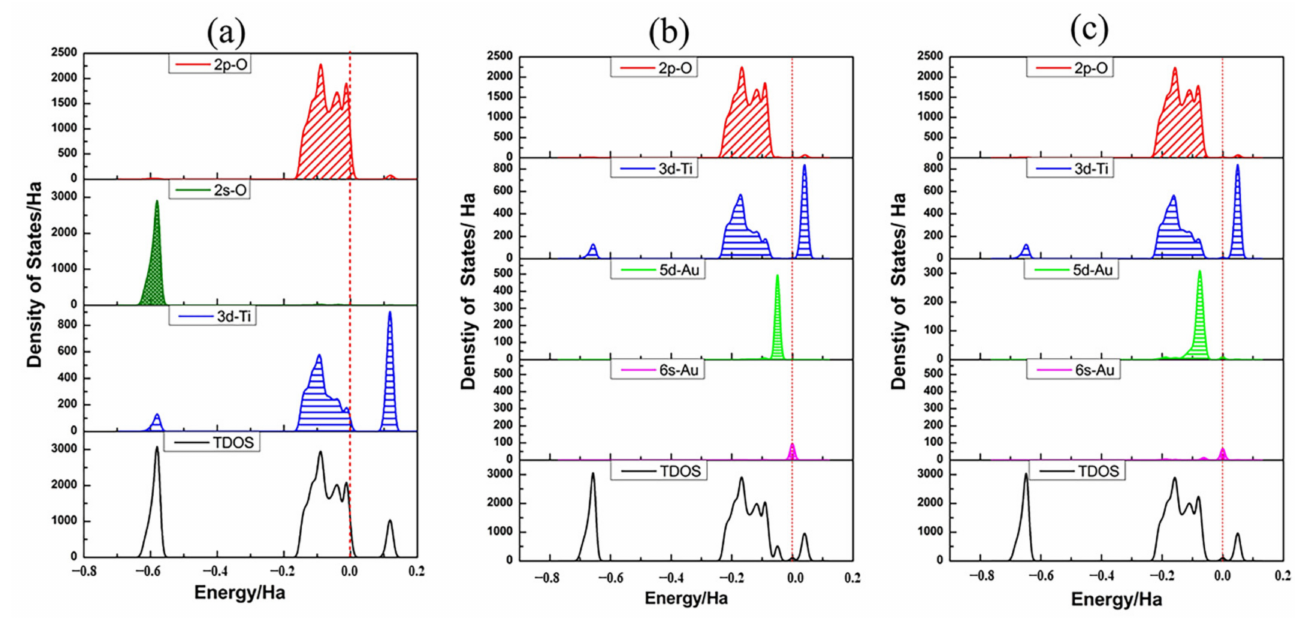
Figure 3. Density of state profiles and the partial density of states of TiO 2 NT (6,0) and Au and relevant nanotube surface atoms for a single Au adatom in two different adsorption states: ( a ) bare TiO 2 NT (6,0), ( b ) Au 1(O,O) , ( c ) Au 1(O,Ti) . The black curve is the sum of PDOS of O atoms, Ti atoms, and Au atoms from the optimized bare TiO 2 NT (6,0)/Au systems, while the red curve indicates the 2 p orbital of oxygen atoms, the dark green curve indicates the 2 s orbital of oxygen atoms, the blue curve represents the 3 d orbital of titanium atoms, the light green curve denotes the 5 d orbital of gold atoms, and the magenta curve represents the 5 s orbital of gold atoms, respectively. The Fermi level of bare TiO 2 NTs is set at 0 eV, as denoted in the red dashed